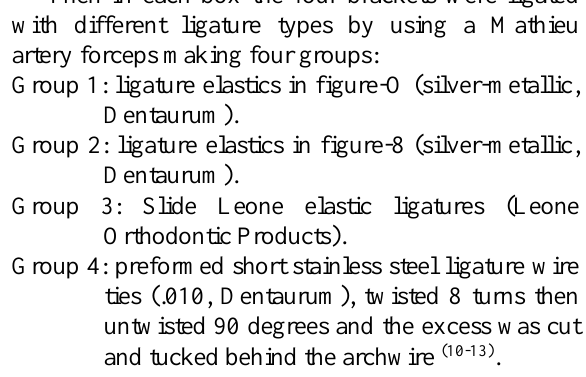
Group 1: ligature elastics in figure-O (silver-metallic, Dentaurum). Group 2: ligature elastics in figure-8 (silver-metallic,